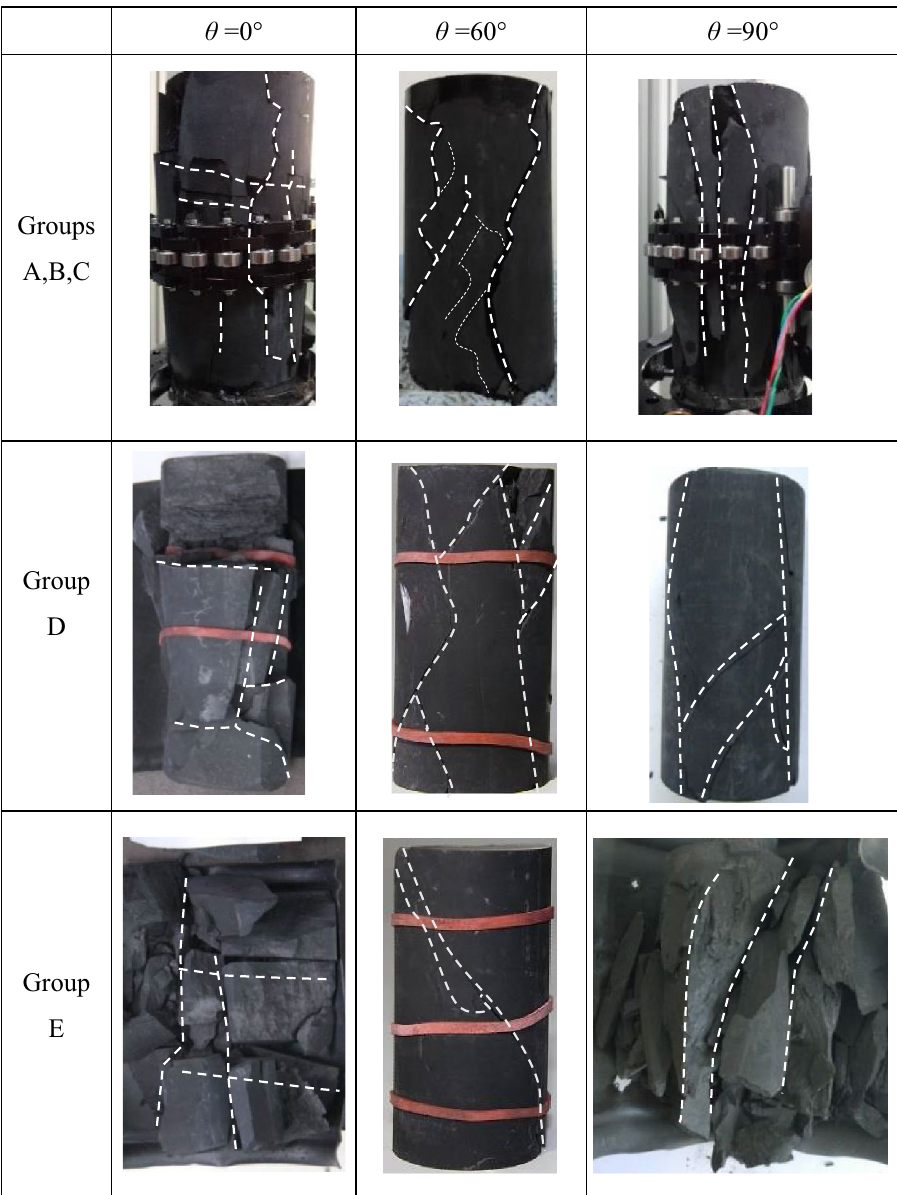
Figure 11. Final fracture morphology of shale specimens with different bedding dip angles during constant strain rate experiments and dynamic cyclic loading tests at different stress